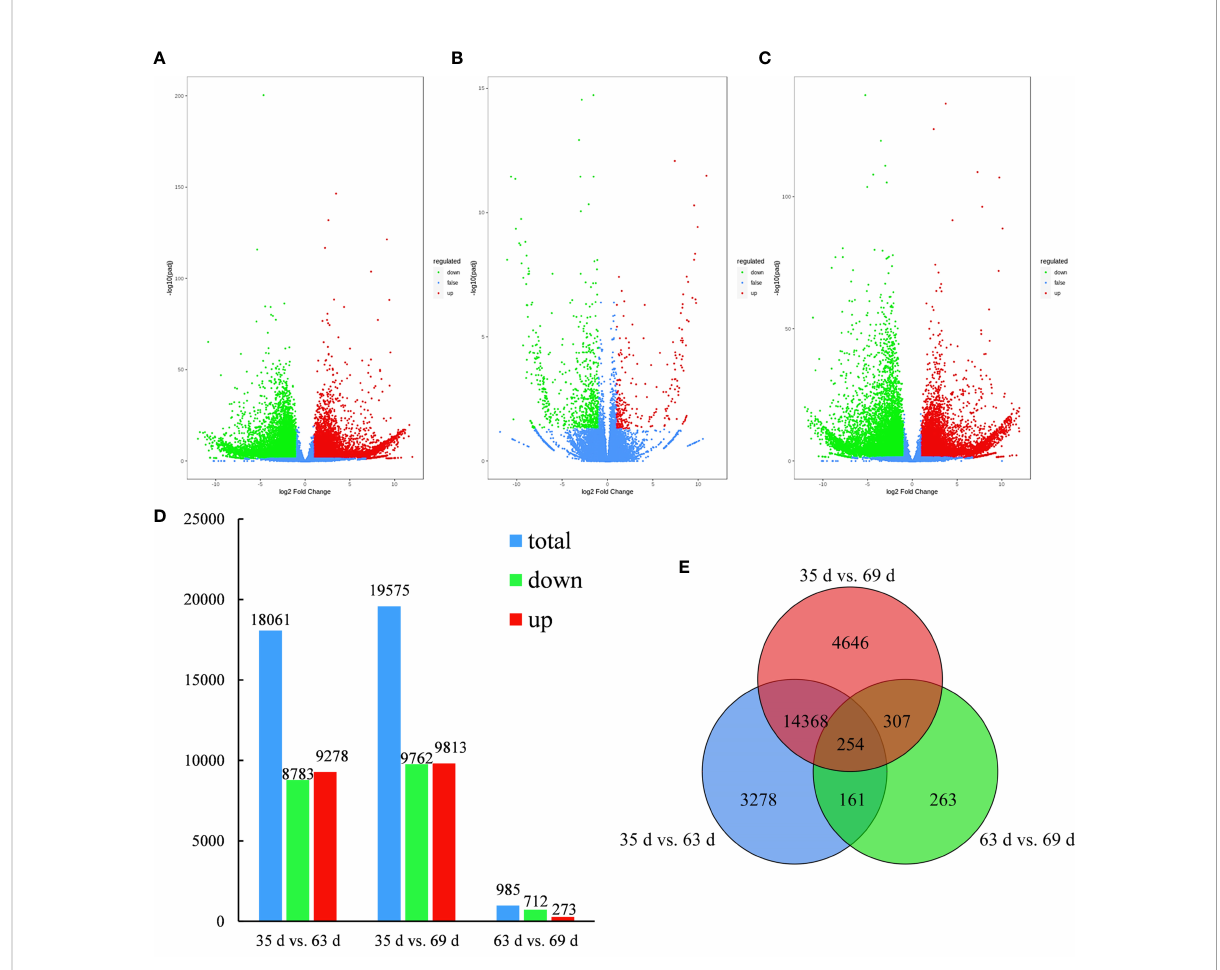
FIGURE 3 Volcano plot, bar plot and Venn diagram of differentially expressed genes. (A – C) The volcano plot of 35 d vs. 63 d, 63 d vs. 69 d, 35 d vs. 69 d. (D) Bar plot of differentially expressed genes generated by a comparison of 35 d vs. 63 d, 35 d vs. 69 d, 63 d vs. 69 d. (E) Venn diagram of differentially expressed genes generated by a comparison 35 d vs. 63 d, 35 d vs. 69 d, 63 d vs. 69